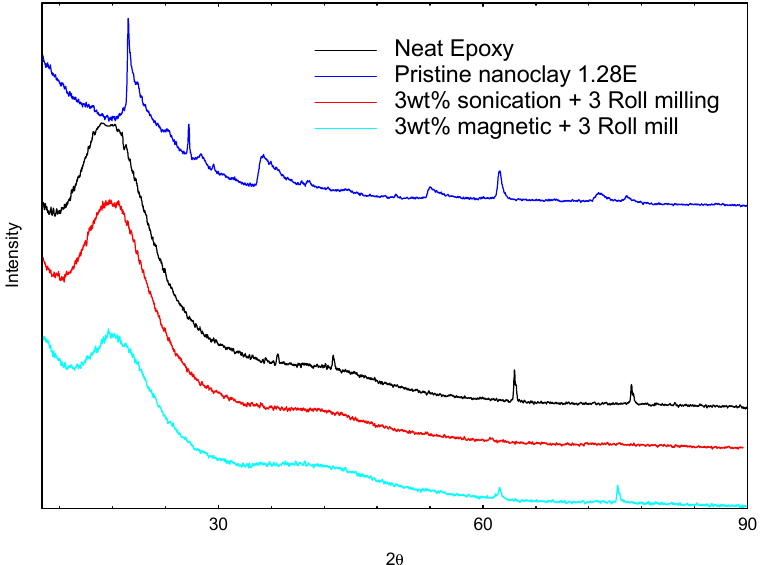
Figure 3. X-ray diffraction for pristine nanoclay, neat epoxy and nanocomposite polymer of 3 wt.% for sonication and magnetic mixing